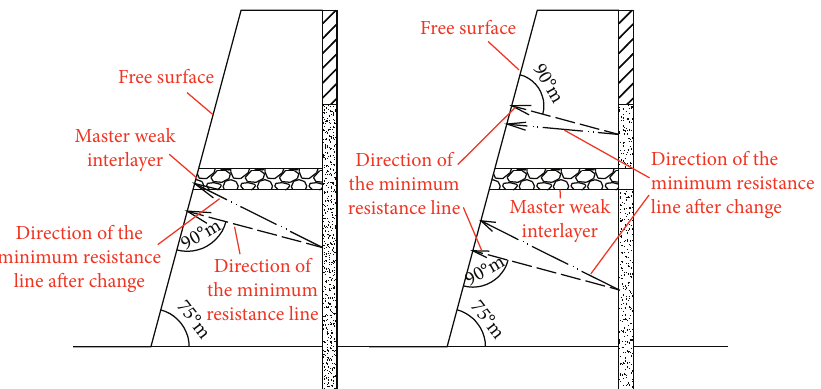
Figure 8: Principle of minimum resistance